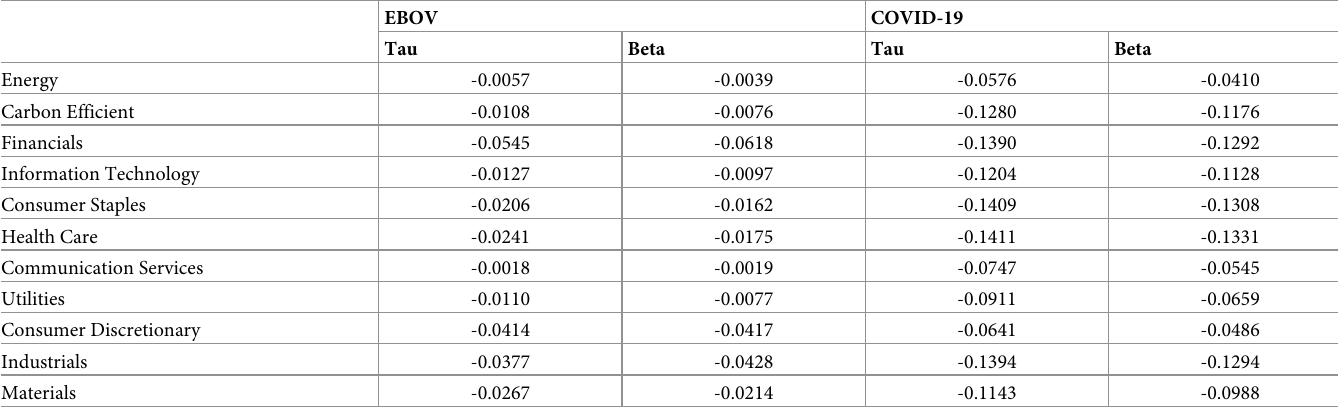
Table 9. The result of Kendall’s tau and Blomqvist’s beta coefficients of bivariate copula for EBOV and COVID-19 periods.